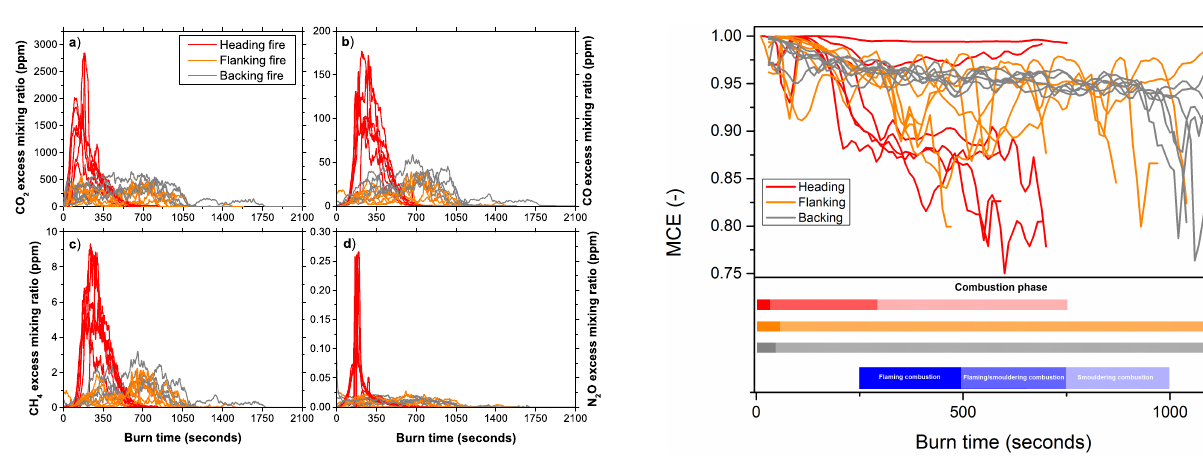
Figure 6. Time series of MCE for the experimental burns. The com- bustion phase for each fire spread mode is split into the duration of flaming, flaming and smouldering and smouldering